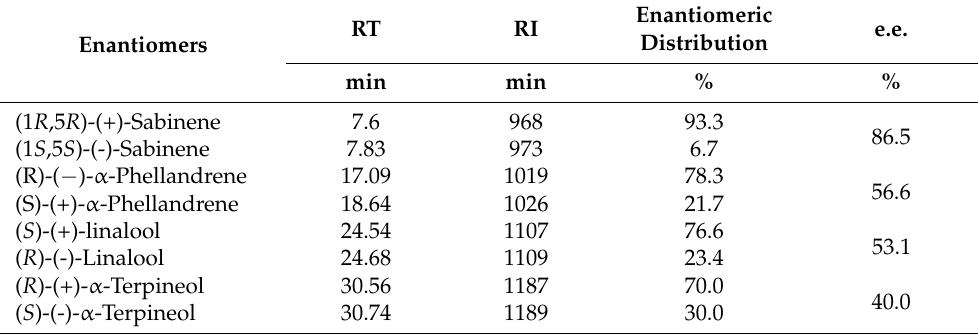
Table 2. Enantioselective analysis of various chiral constituents of essential oil from Piper carpunya . Enantiomeric RT RI Enantiomers